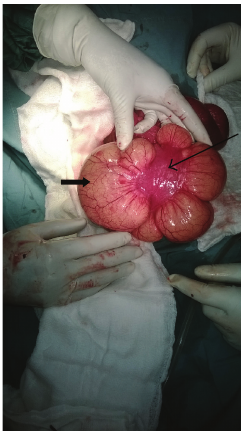
Figure 3: Intestine (long arrow) compressed by the cyst (short arrow).